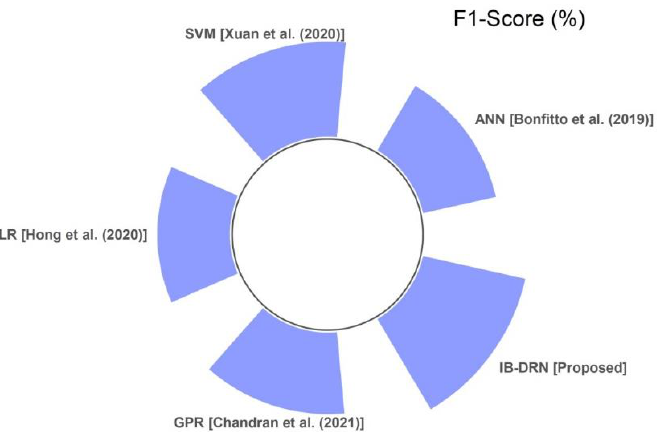
Figure 6. F1 score outcomes of proposed and existing referenced [1,28–30] methodologies. Figure 6. F1 score outcomes of existing and proposed methodologies [GPR [Chandran et al. (2021)], LR[Hong et al. (2020)], SVM[Xuan et al. (2020)]].